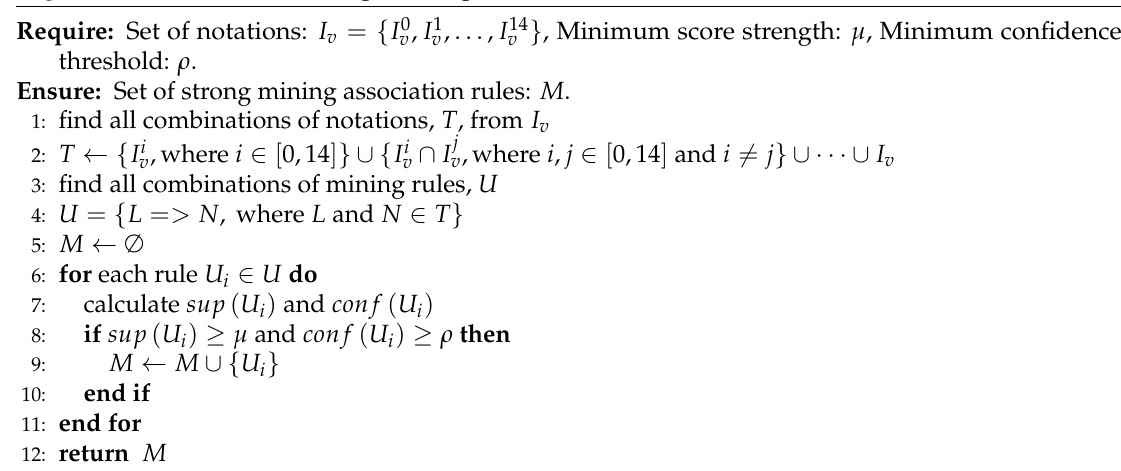
Algorithm 3 Association mining rules